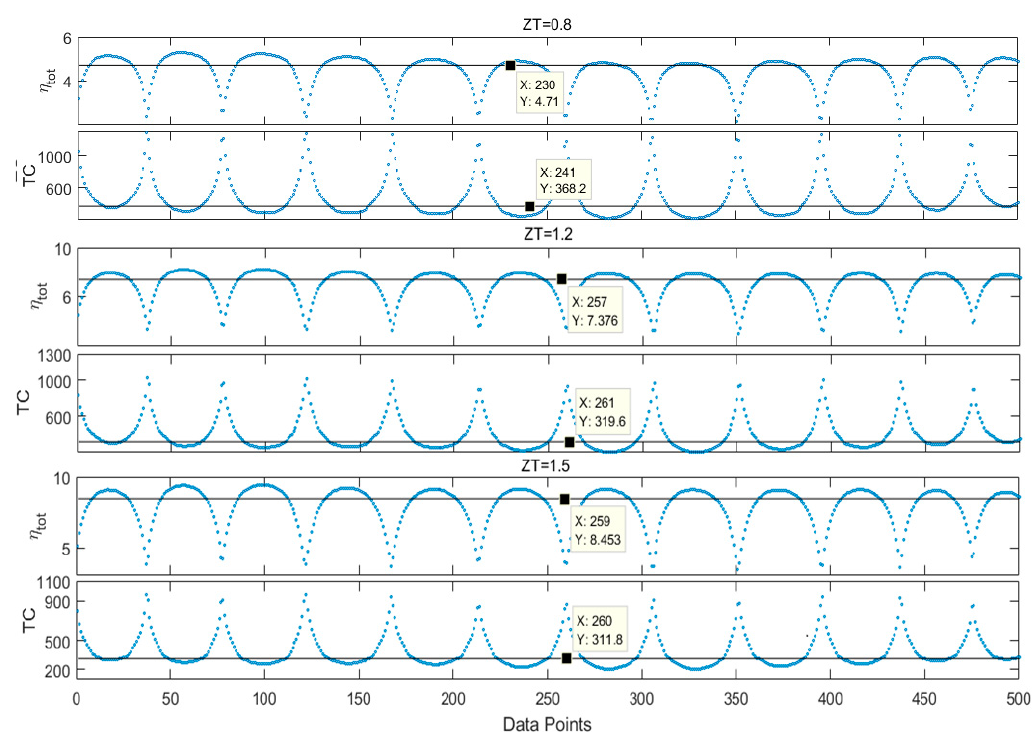
Figure 10. Maximum efficiency and optimum TC in Gibraltar. Black lines are the weighted average for a year and blue dots are the value for each point. X axes are data points, each point represents 15 min of sunshine. Energies 2018 , 11 , x FOR PEER REVIEW